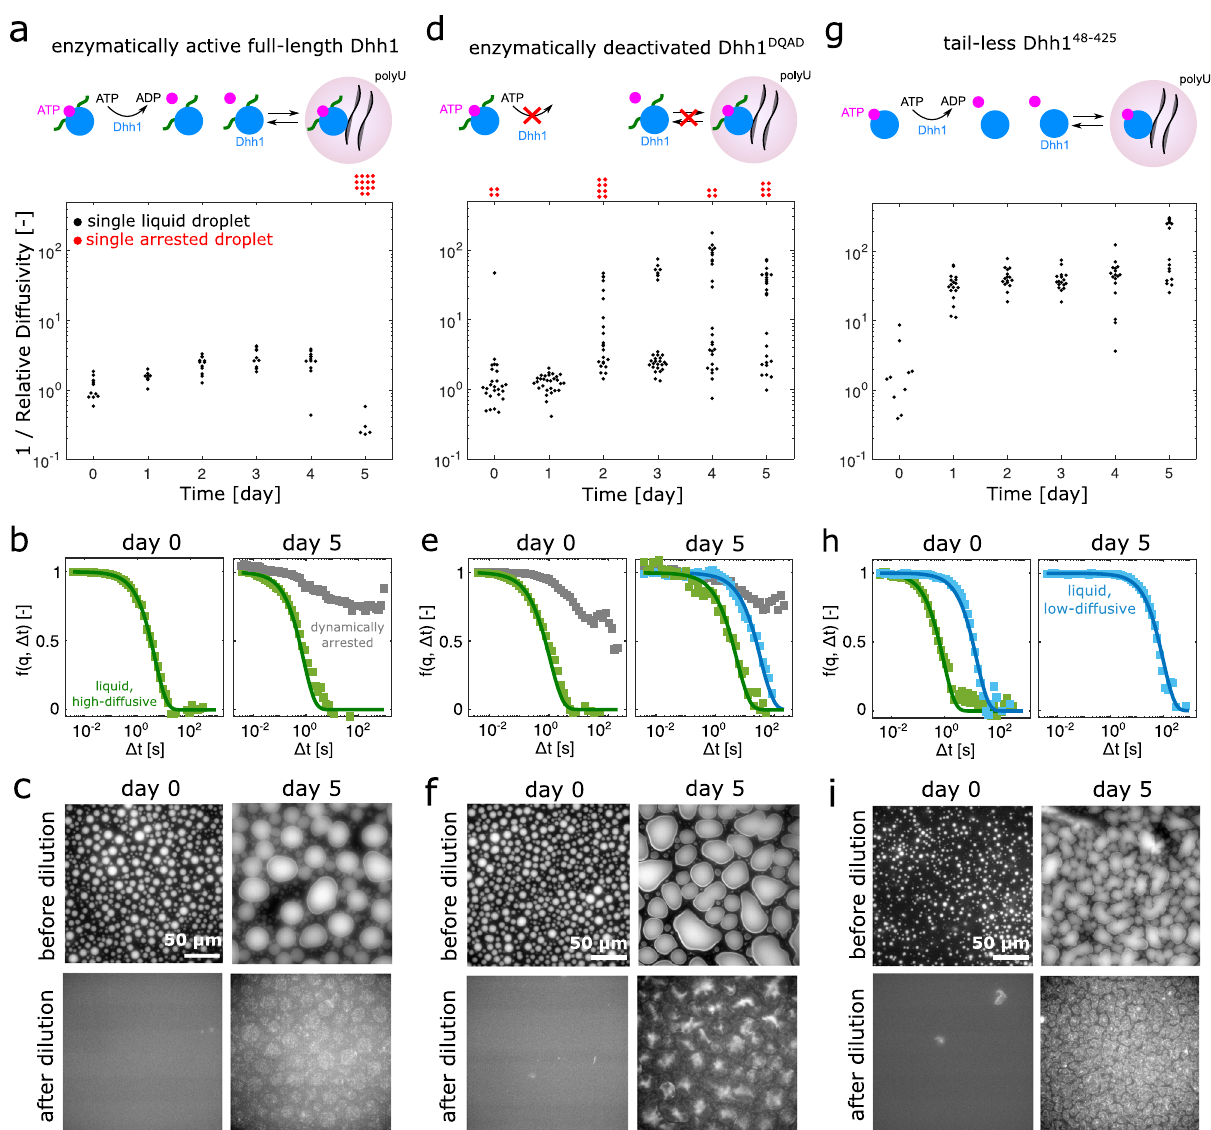
Fig. 5 Material properties of enzymatically active full-length Dhh1, enzymatically deactivated Dhh1 DQAD , and the LCD-lacking variant Dhh1 48 – 425 . The reciprocal of the relative diffusion coef fi cient (1 / Relative Diffusivity = 〈 D 0 〉 / D ( t )) of the condensates as well as the fraction of dynamically arrested gel-/ glass-like droplets were measured over a time course of 5 days. D 0 and D ( t ) are diffusion coef fi cients at time zero and time t , respectively. Each dot represents a single droplet. a Full-length Dhh1 droplets remain liquid over several days (black dots) and only a fraction of the droplets becomes dynamically arrested on day 5 (red dots). These droplets deviate from liquid-like behavior and are therefore displayed outside the graph. b Representative ISFs of droplets of full-length Dhh1 on day 0 (high-diffusive, green) and day 5 (high-diffusive, green; arrested, gray). c Droplets formed with full-length Dhh1 could be reversibly dissolved upon dilution on day 0 but not anymore on day 5, con fi rming the presence of non-liquid, or low-diffusive structures. d In addition to high-diffusive droplets, the catalytically deactivated Dhh1 DQAD variant showed a small fraction of dynamically arrested droplets already on day 0. The number of dynamically arrested droplets increased on day 2 and was accompanied by high- and low-diffusive droplets. e Typical ISFs of Dhh1 DQAD droplets, showing high-diffusive (green) and arrested droplets (gray) on day 0 and high-, low-diffusive (blue) and arrested droplets on day 5. f Also the Dhh1 DQAD droplets could not be dissolved by dilution on day 5, in contrast to full dissolution on day 0. g Droplets formed in the presence of Dhh1 48 – 425 showed a decrease of the diffusivity of about one order of magnitude with respect to Dhh1 after day 1. No dynamically arrested droplets were observed over the time course of 5 days. h Representative ISFs of Dhh1 48 – 425 droplets with high diffusivity on day 0 (green) and of droplets with low diffusivity observed after day 1 (blue). i Also Dhh1 48 – 425 droplets could be dissolved on day 0 but not on day 5. Source data for panels a , d , g are provided in the Source Data fi